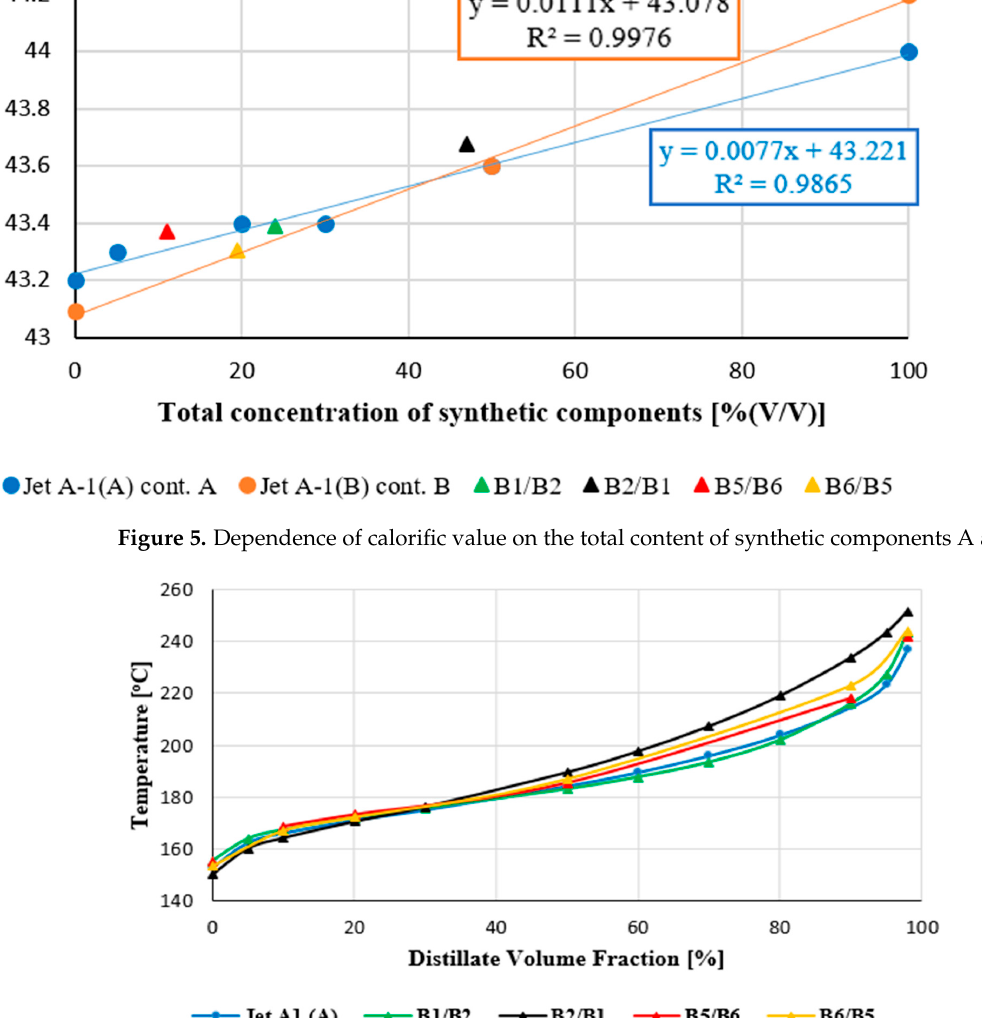
higher concentrations of synthetic components result in a higher Calorific Value. Synthetic component A was added to mineral Jet A-1 fuel in various concentrations, including rel- atively small ones: 5, 20 and 30% ( v / v ). In this range of concentration, the increase in Cal- orific Value is not proportional to the increase in the A component’s concentration. The same trend was found for mixtures consisting of two synthetic components A and B (B1/B2, B2/B1, B5/B6 and B6/B5). Moreover, the values of Calorific Value for these mix- tures lie on or near the line obtained for mixtures containing only component A (dashed blue line). This analysis indicates the interactions between components A and B, which influence the energy effect of combustion processes.